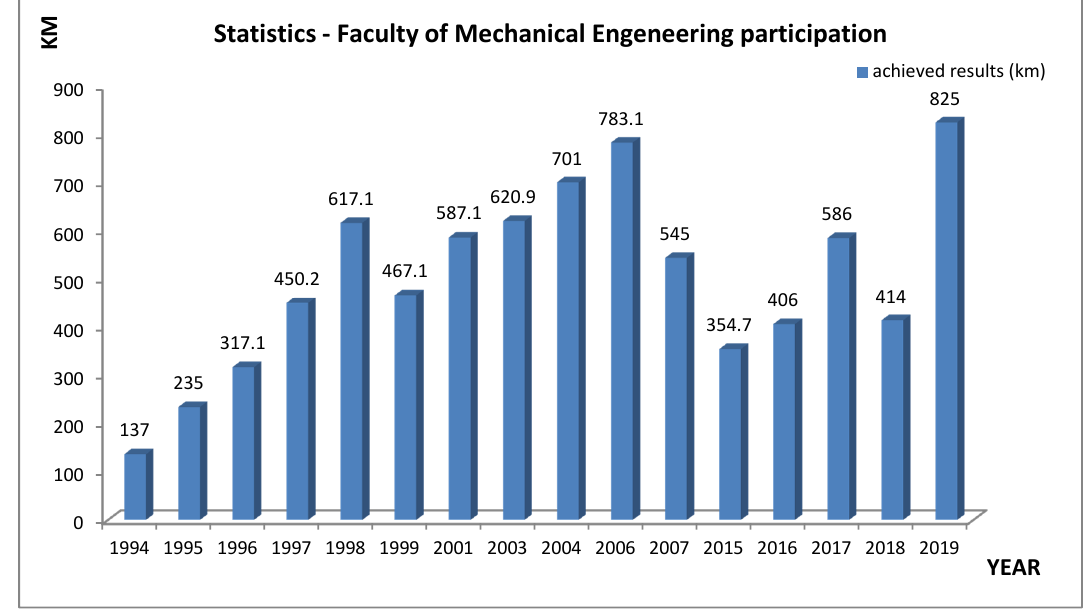
Figure 1. Statistics of the team of the Faculty of Mechanical Engineering of the Technical University of Košice.